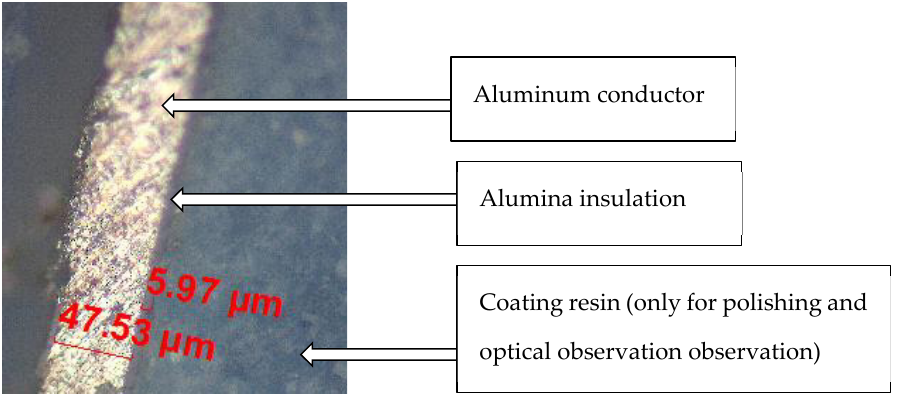
Figure 2. Microscopic section of the tape (×500).